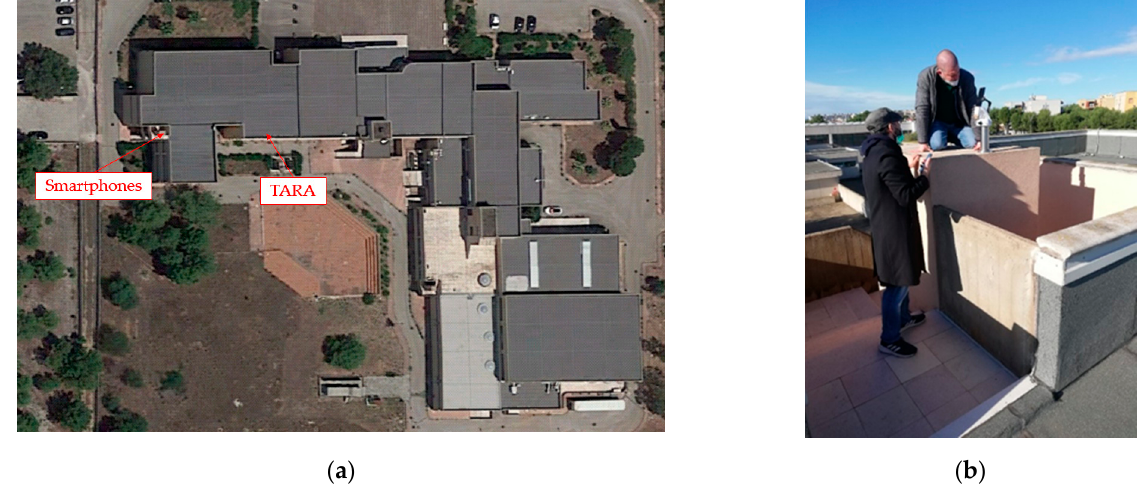
Figure 1. Positioning of the smartphone on the rooftop of the building and approximate location of smartphones and TARA GNSS Permanent Station: ( a ) image extracted from Google Earth; ( b ) panoramic photo of the smartphone on the test site.